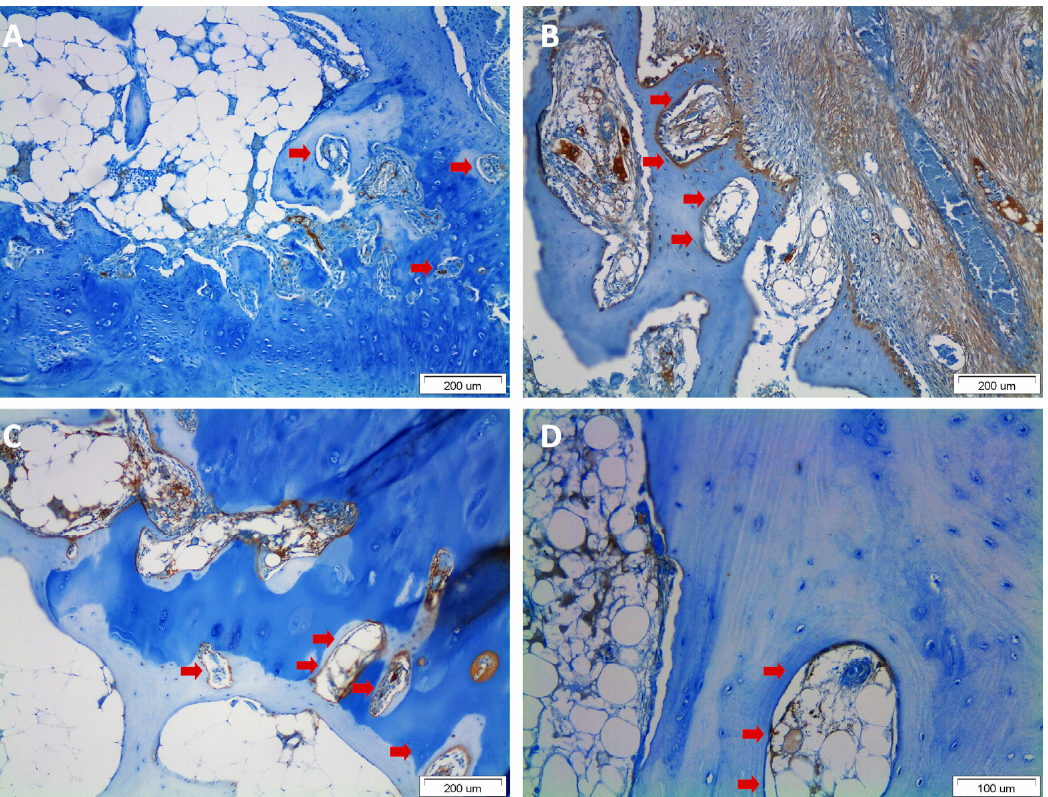
Figure 2. Representative immunohistological photomicrographs of subchondral bone cysts (SBCs) in sections of osteoarthritis patients. Note the thin layer of fibrous connective tissue covered by lining cells and osteoblasts. ( A ) Small-sized SBCs (red arrows) in the section of a patient with Mankin score 3 (original magnification × 10). ( B ) Large SBCs containing fibrous tissue surrounded by osteoblasts in the section of a patient with a Mankin score of 8 (original magnification × 10). ( C ) SBCs in a slice from a patient with a Mankin score of 7 (original magnification × 10). ( D ) Bone lining cells covering the cavity of a large SBC in a patient with a Mankin score of 8 (original magnification × 20).